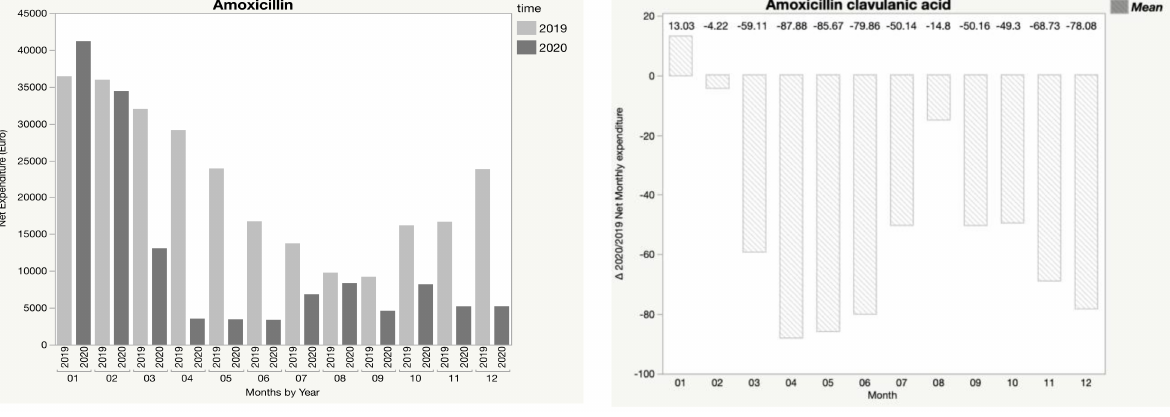
Figure 3. Trend in net expenditure (EUR) and delta 2020/2019 of net monthly expenditure of amoxicillin–clavulanic acid, from January through December of the years 2019 and 2020, in the study population of 35,787 children aged 0–14